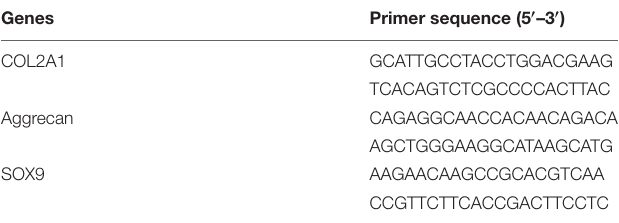
TABLE 1 | Primer sequences of related genes. Genes